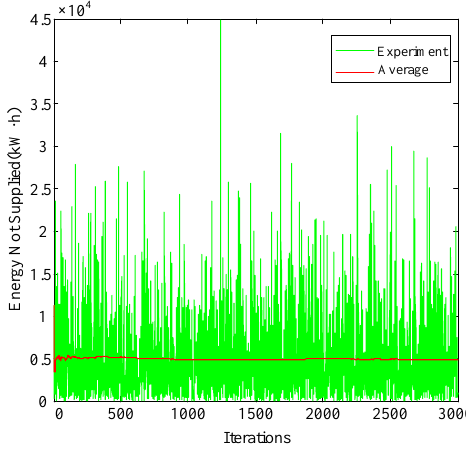
Figure 4. Expected energy not supplied for the copper